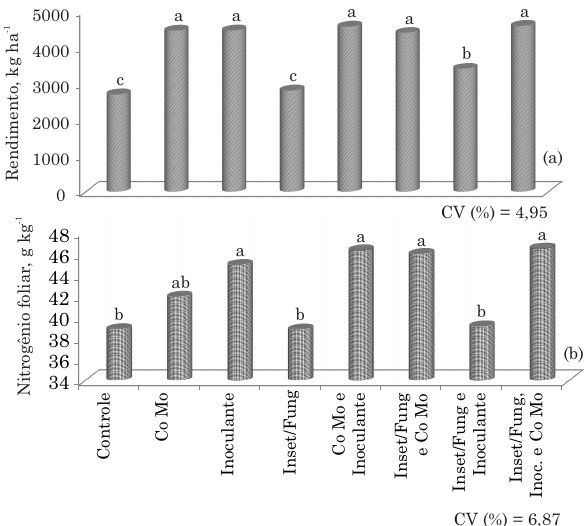
Figura 3. Rendimento de grãos (a) e teor de nitrogênio foliar (b) da soja (BMX Magna RR) em função de diferentes tratamentos de sementes. Safra 2010/11. Médias comparadas com mesma letra não diferem pelo teste de Tukey (p<0,05).